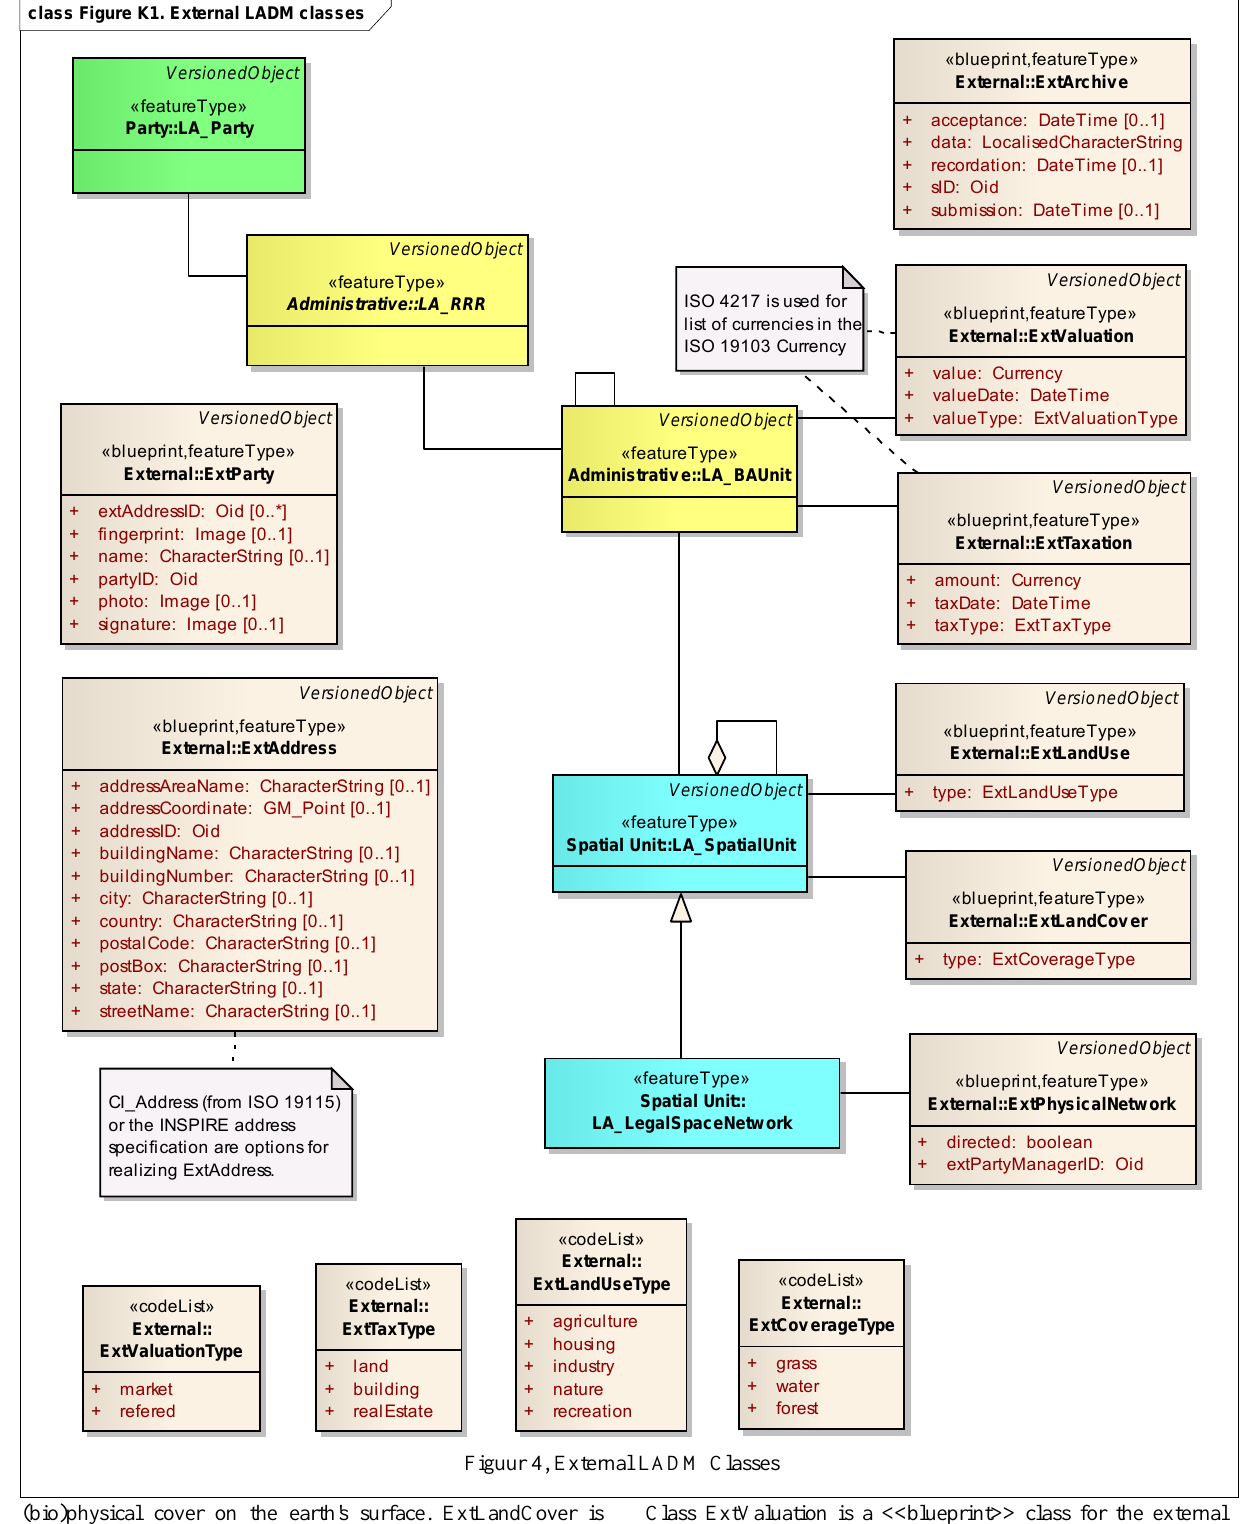
class Figure K1. External LADM